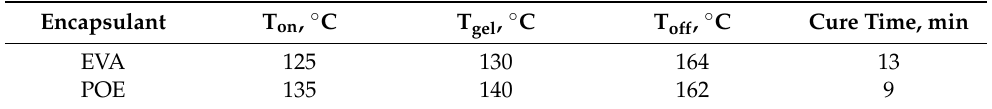
Figure 2. Temperature-rise DMA curves of the investigated peroxide-crosslinking EVA and POE grades (T on . . . onset temperature, T gel . . . gelation temperature, T off . . . offset temperature). Table 1. Onset, gelation and offset temperatures as well as total curing time of UV-transparent, fast-cure EVA and POE